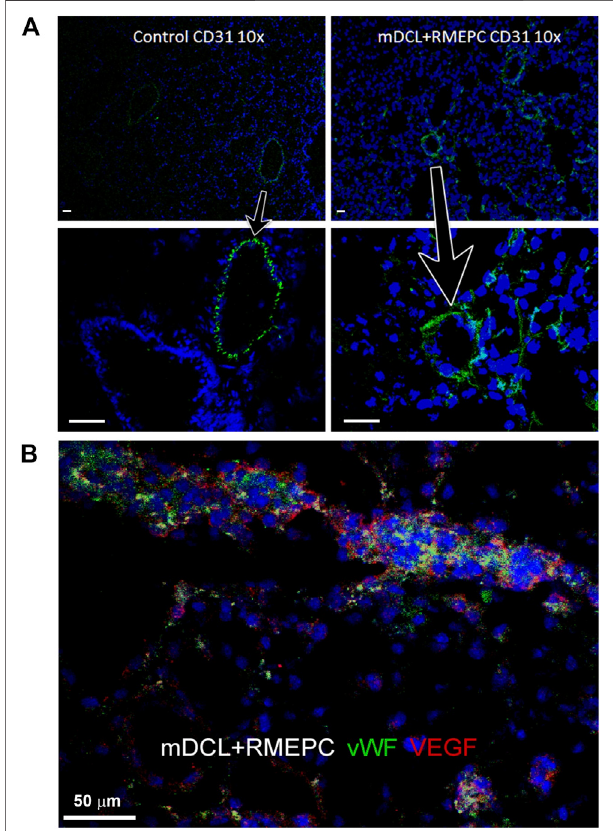
FIGURE 4 | RMEPC express endothelial markers after reseeding on decellularized mouse lungs. (A) PECAM-1 (CD31) expression in rat lung control and recellularized lungs. Images taken at × 100 magni fi cation, × 10 objective; DAPI nuclear stain in blue. Arrows point to zoomed areas. (B) Immuno fl uorescence of representative image of RMEPC-recellularized lungs at × 630 magni fi cation ( × 63 objective) showing expression of von Willebrand factor (vWF)and vascularendothelialgrowth factor(VEGF).DAPInuclearstain in blue. Scale bars set to 50 µm in each